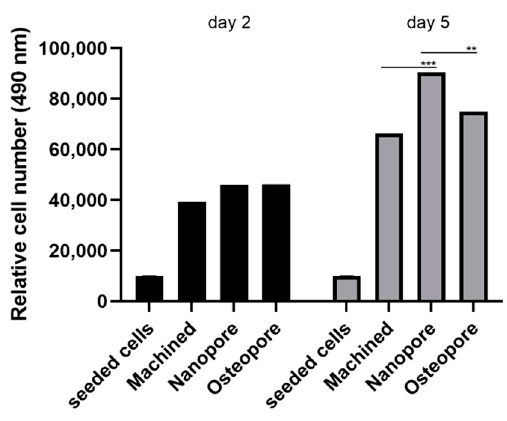
Figure 3. Cell proliferation analysis of osteoblasts seeded on Ti discs. The histogram shows the en- hanced proliferation for cells cultured on Nanopore (+36.53 ± 0.13%) and Osteopore (+13.03 ± 0.19%) surfaces with respect to Machined at day 5. Data are expressed in the form of relative cell number seeded on the discs as mean±SD. All standard deviations resulted between 0.02 and 0.19. (** p ≤ 0.001; *** p ≤ 0.0001; Machined vs. Nanopore p = 0.0001; Nanopore vs. Osteopore p = 0.001) .